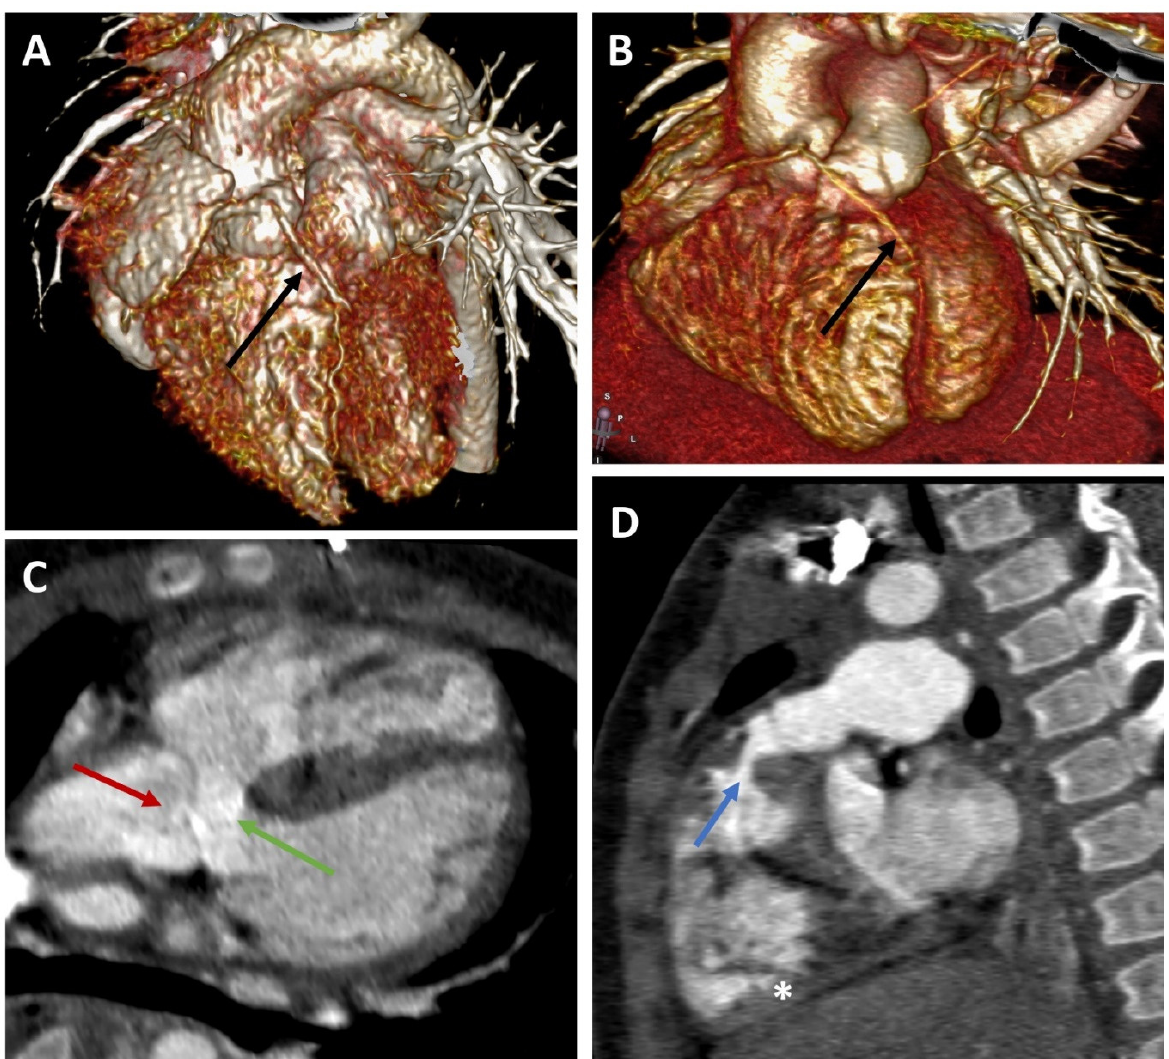
Figure 1. Representative CT angiography images. ( A , B ) Volume-rendering technique (VRT) recon- structions for CT images of 2 patients with Fallot tetralogy (ages: 7 and 14 months). Black arrow: anomalous course of the left anterior descending artery over the right ventricle outflow tract (RVOT). ( C , D ) Double oblique reconstruction of CT images in an infant with Fallot tetralogy. Red arrow: Mildly dilated aortic root overlapping the interventricular septum. Green arrow: Ventricular septal defect. Blue arrow: Narrowing of the right ventricular outflow tract (subpulmonary stenosis). The right ventricle (star) is mildly hypertrophied.